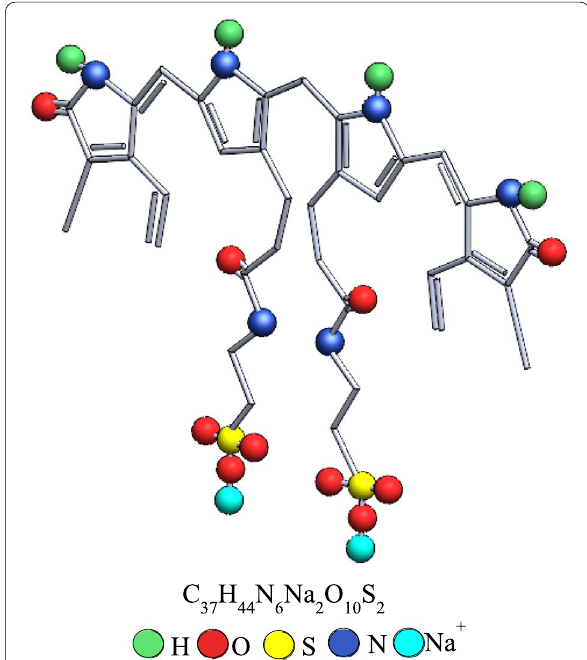
Fig. 1 The molecular formula and 3D structure of the direct bilirubin sample